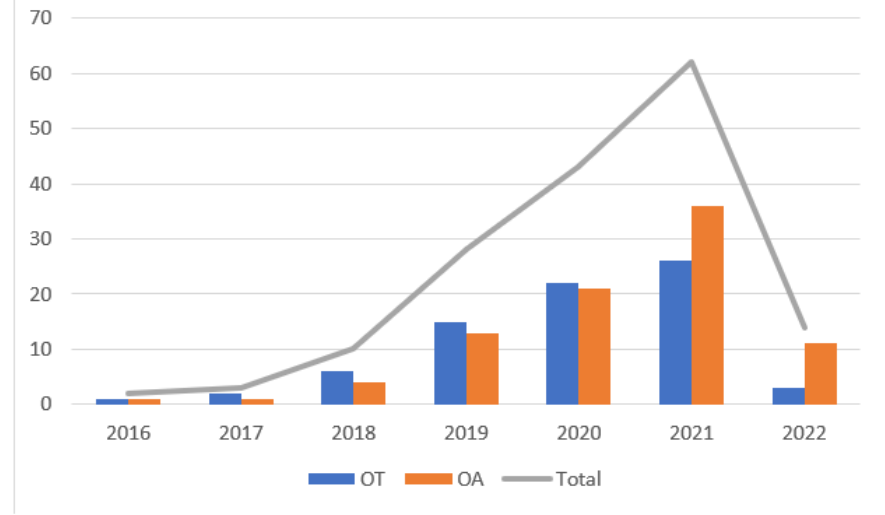
Figure 3. Publications per year. Table 4. Distribution among the ten most productive